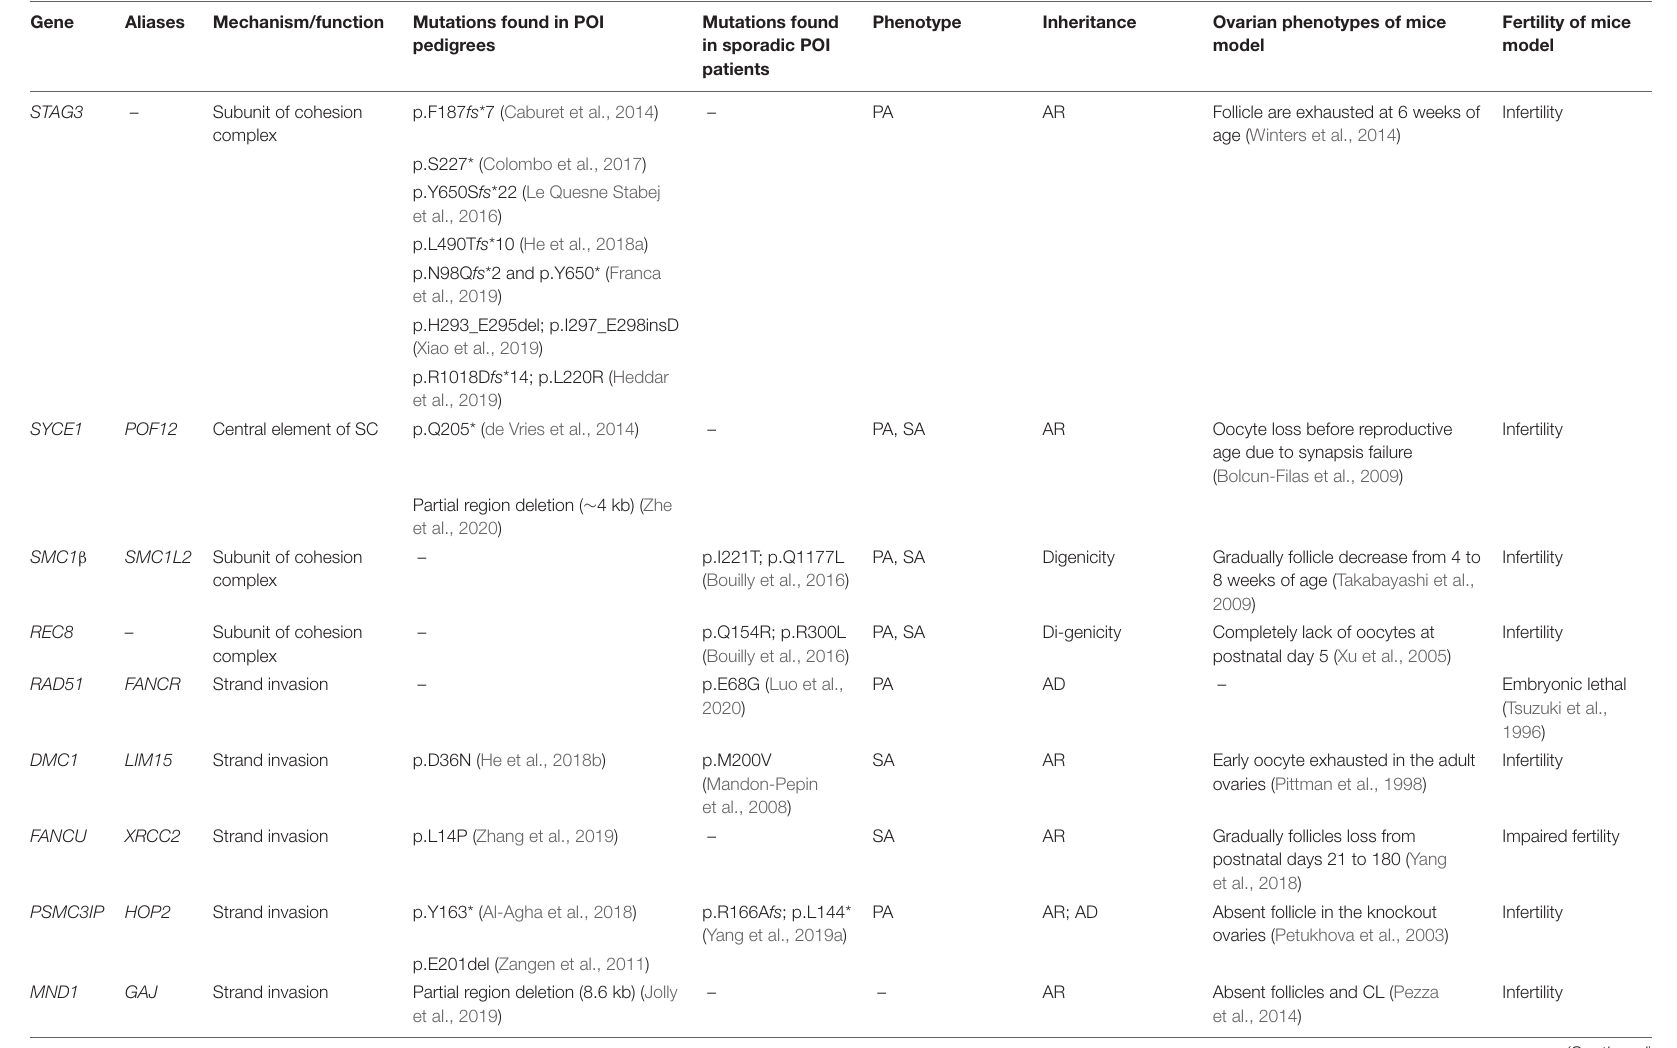
TABLE 1 | Variants of meiosis HR genes identified in POI patients.